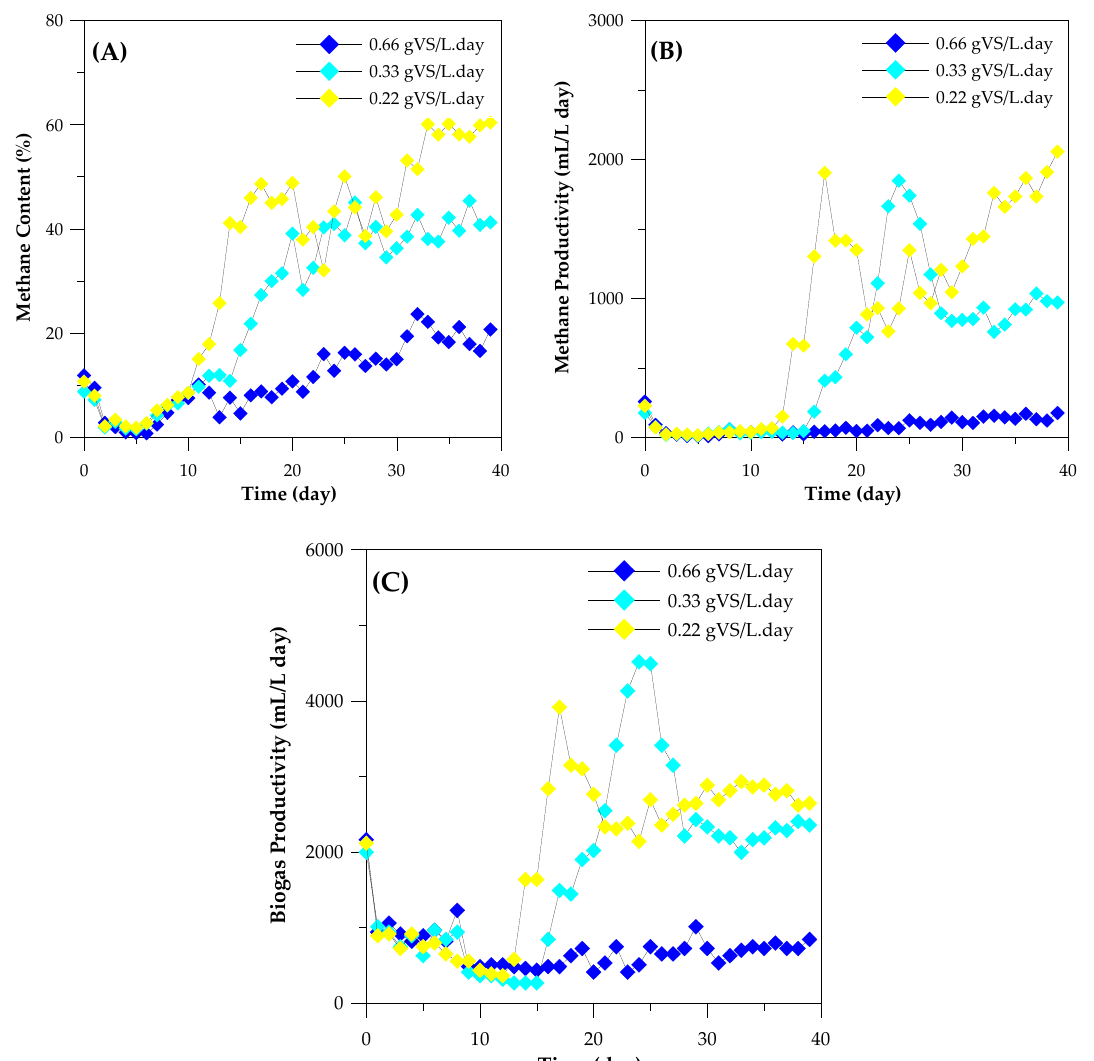
Figure 3. Biogas performance of co-digestion of canteen food waste and domestic wastewater in a semi-continuous experiment. Daily results for ( A ) methane content, ( B ) methane productivity, and ( C ) biogas production rate are shown.